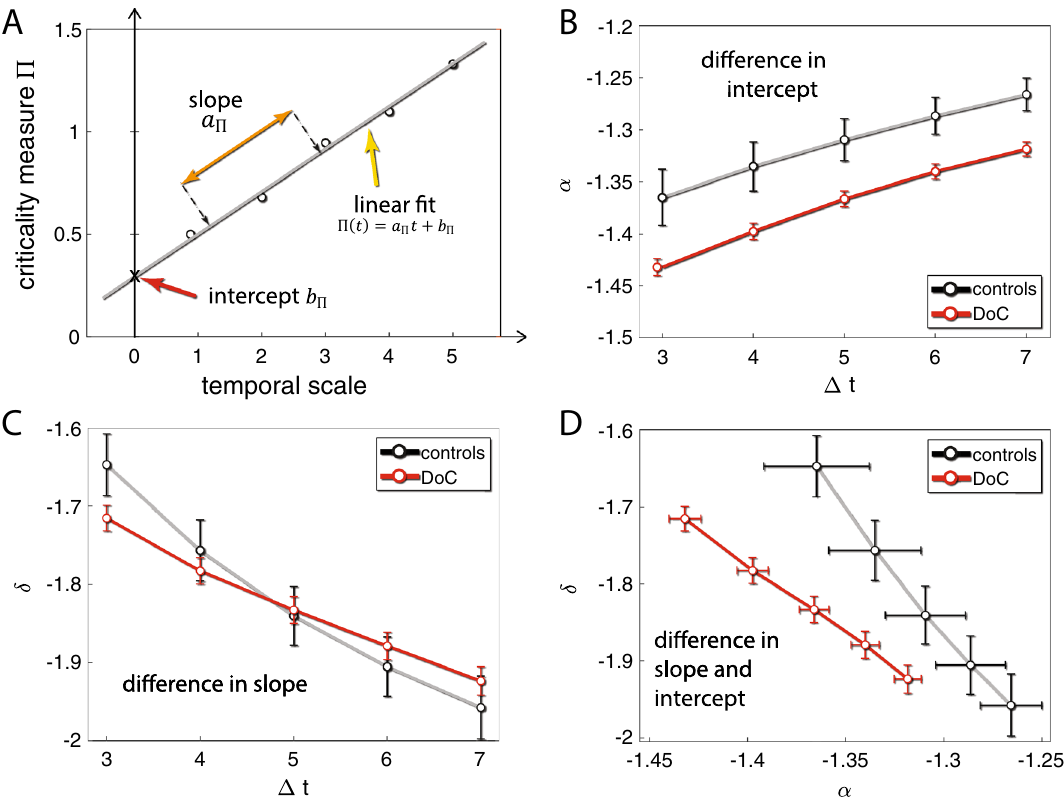
Figure 2. Deriving MsCr measures from standard criticality measures. ( A ) an illustration of deriving MsCr measures. Exponents characterizing a given aspect of the distribution of neuronal avalanches in an experimental condition (e.g. of the distribution of avalanche sizes during sleep) are computed across several temporal scales. They are then fit with a line, and the slope and intercept are taken to represent the multiscale temporal behavior of a subject in a given state of the brain. ( B ) Difference in experimental condition can manifest in difference in intercept—in this case between subjects suffering from disorders of consciousness (see details below) and controls for the avalanche size distribution. ( C ) Difference in experimental condition can manifest in difference in slope—here for the inter-avalanche interval (IAI) across temporal scale (same data as B ). ( D ) Difference can also manifest in both slope and intercept—in this case in the joint behavior (interaction) of avalanche size and IAI when temporal scale Before further analysis, data were down sampled to 250 Hz. Additionally, data from 2 broken sensors were removed for all subjects.